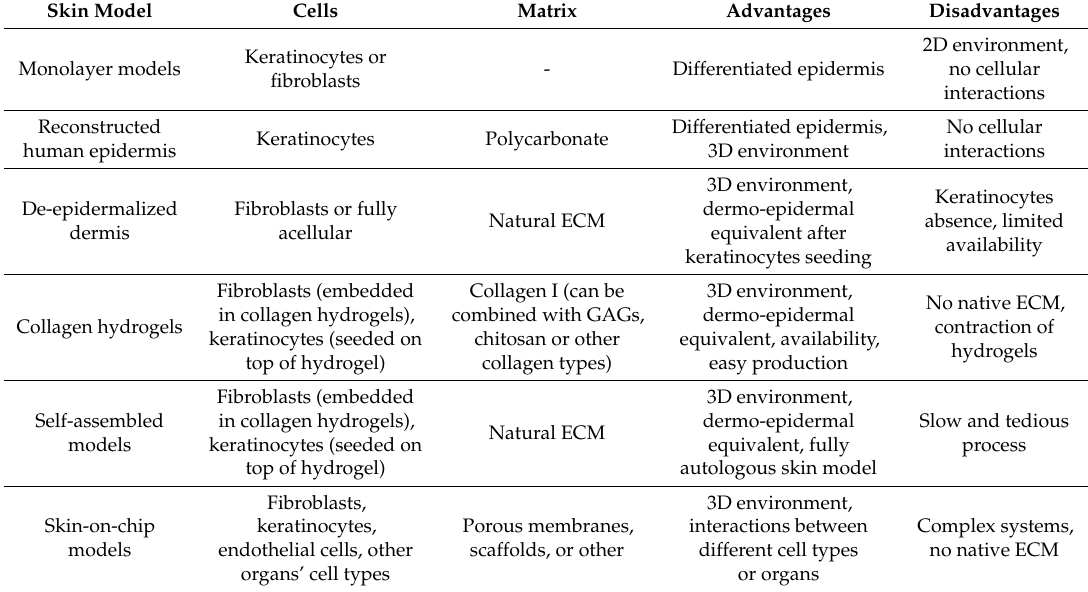
Table 1. Different skin models applicable to skin disease modeling, along with their advantages and